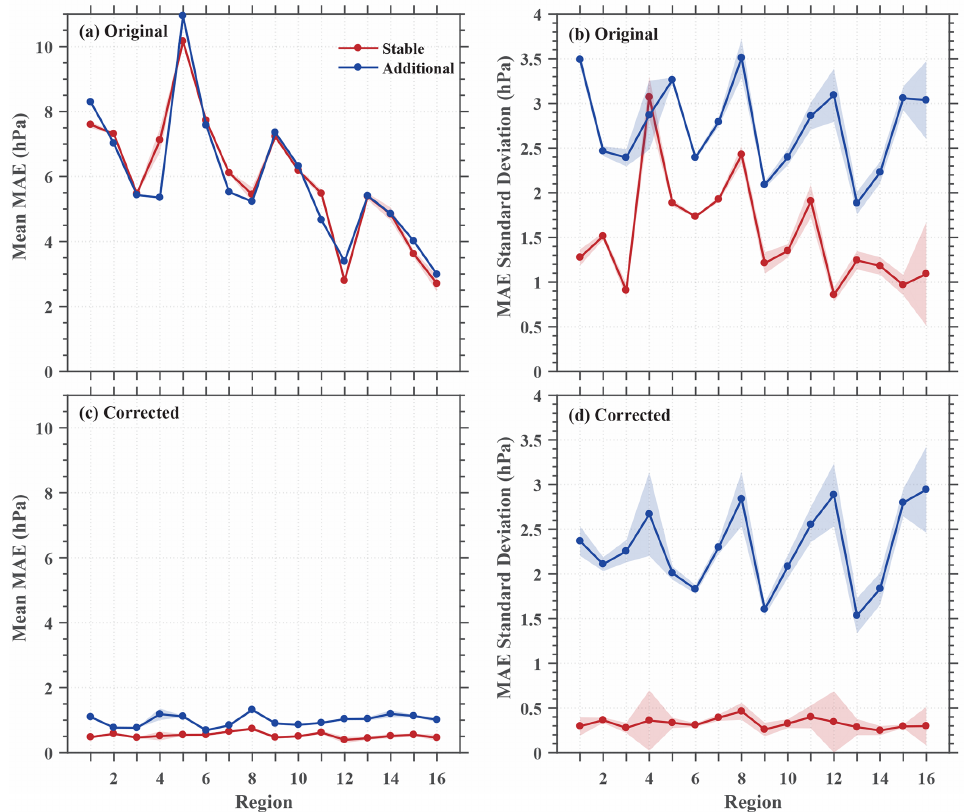
Figure 10. Distribution of domain-average mean absolute error (MAE; a , c ) of ensemble mean and standard deviation (b, d) for different subdomains for the original dataset (a, b) and the bias-corrected dataset (c, d) . The line marked by dots is the ensemble mean value, and shading is the double standard deviation ensemble spread. The red line is the result for stable sites, and the blue line is the result for additional sites. See text for the definitions of stable sites and additional